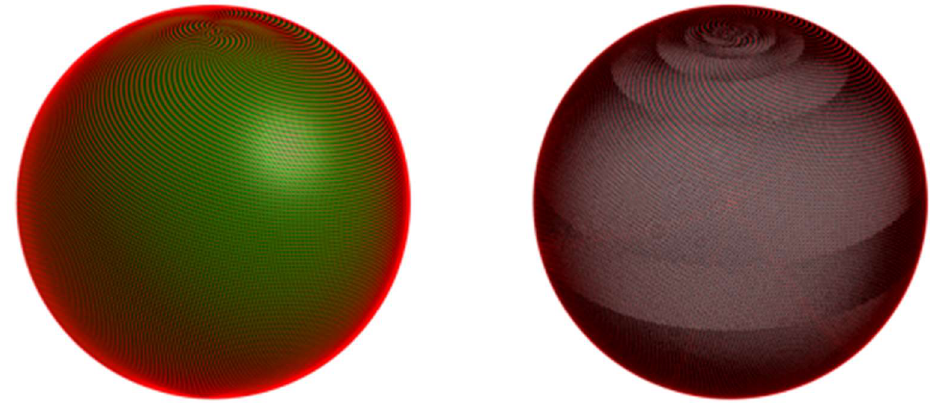
F Figure 9. Schematic overview of the proposed algorithm. 4. Simulation Results and Analysis 4.1. Simulation Conditions To thoroughly test the proposed algorithm, Monte Carlo simulations were con-